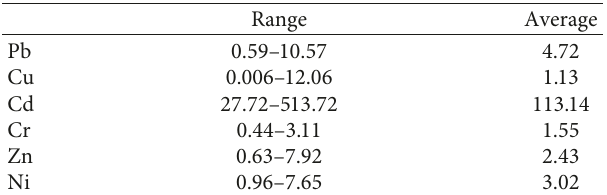
Table 8: Biological assessment index values P calculated for heavy metals in Rades-Hamam Lif surface